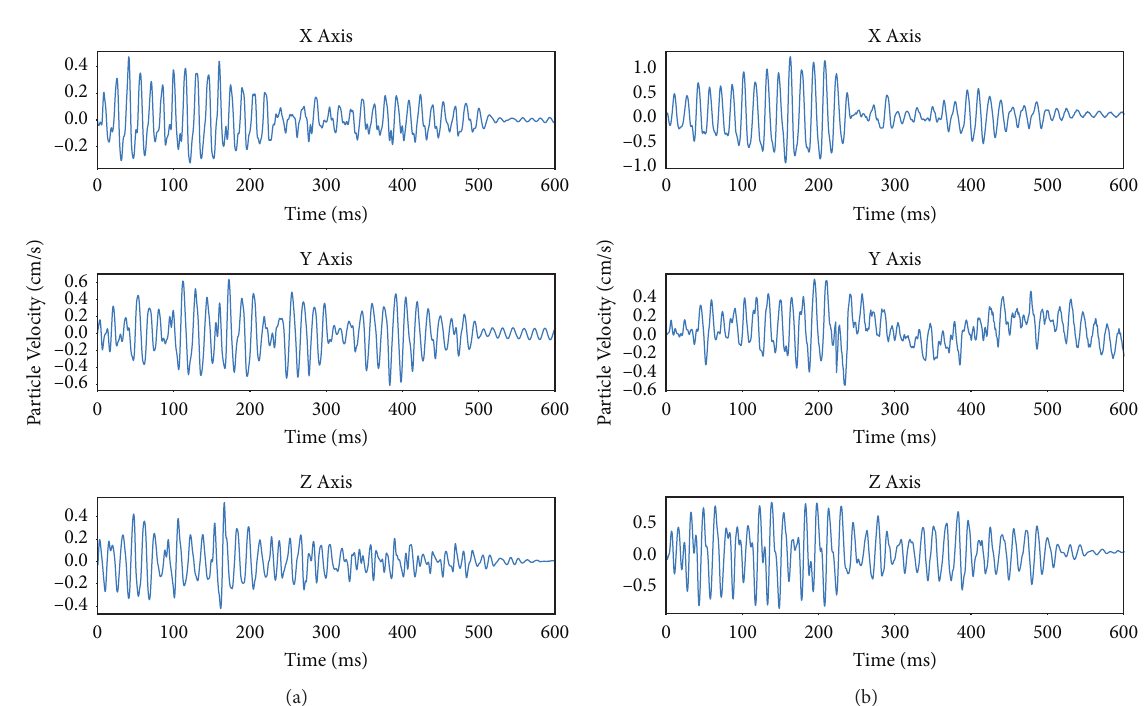
Figure 7: Typical time history curves of vibration velocity: (a) monitoring point 2 at +10m; (b) monitoring point 5 at − 10